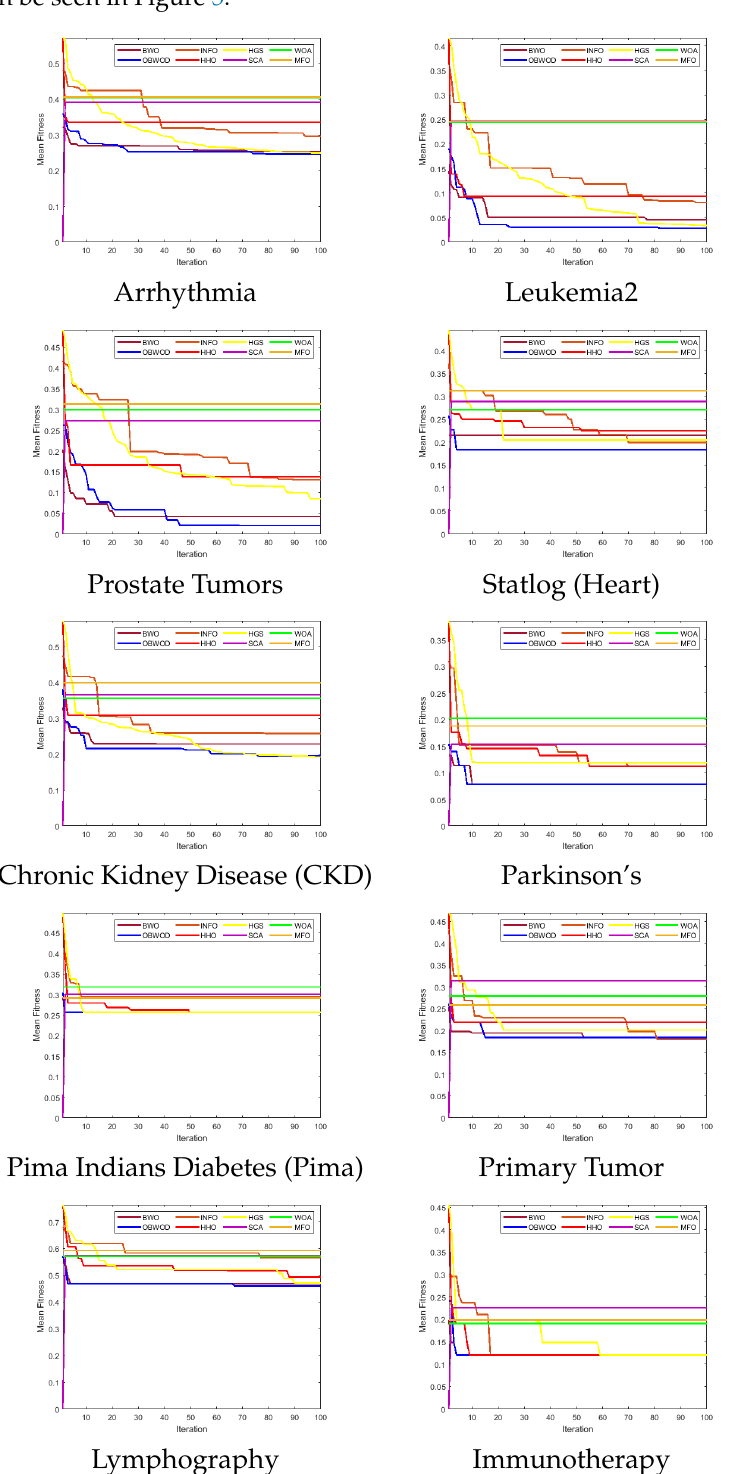
Figure 4. Convergence curves of OBWOD and other optimization algorithms based on the kNN